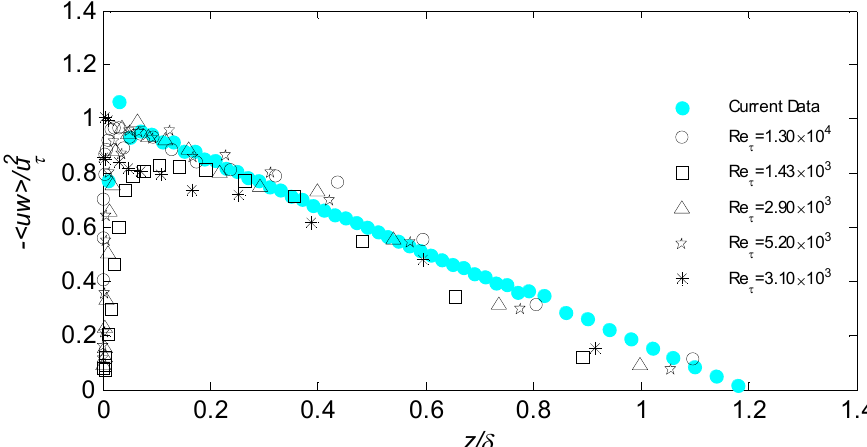
Figure 6. Comparison of − uw / u 2 τ in results of outer-scaled height simulation with the experimental data. The solid colored circles indicate current simulation data, the open symbols are experimental data, the squares show Re τ = 1.43 × 10 3 , the upper triangles symbol give Re τ = 2.9 × 10 3 , the stars indicate Re τ = 5.2 × 10 3 , the circle symbols represent Re τ = 1.3 × 10 4 , and the eight-spoked asterisks are Re τ = 3.1 × 10 4 .